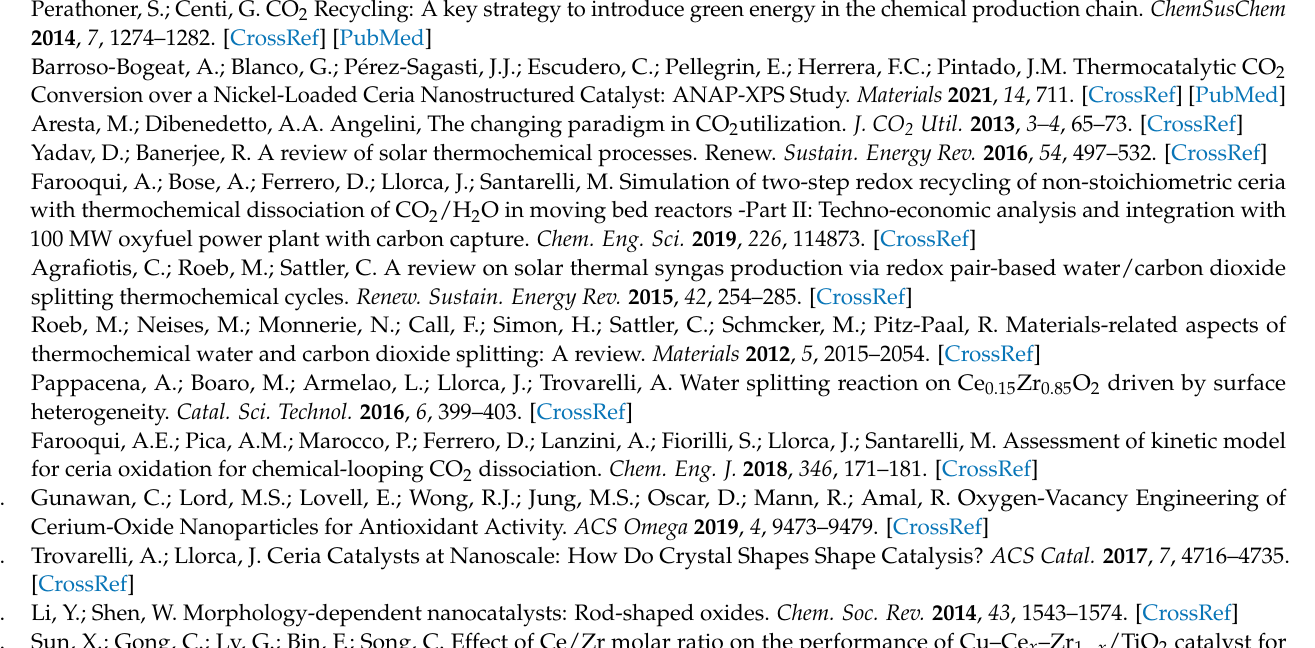
Figure S2. N 2 adsorption-desorption isotherms (a) and pore size distribution (b); Figure S3.